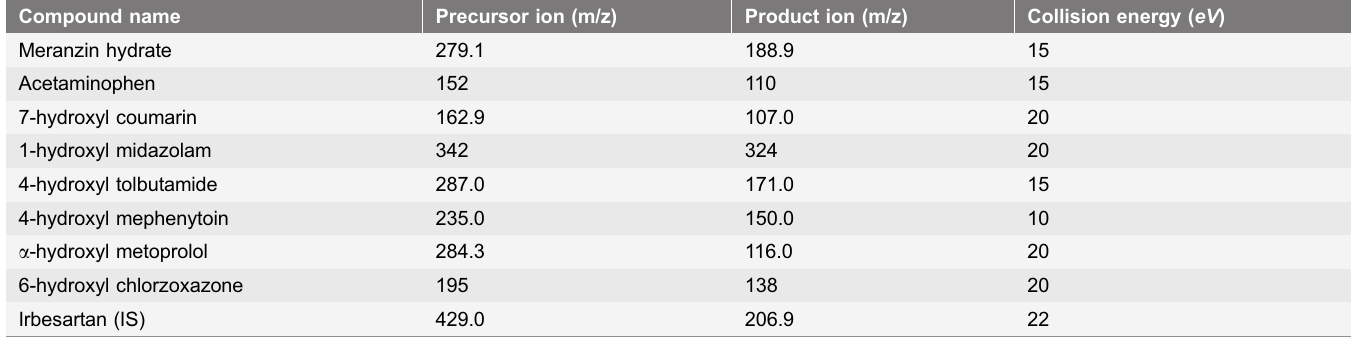
Table 1. Transitions and collision energies used in LC-MS/MS for the detection of meranzin hydrate, the probe substrates, metabolites and the internal